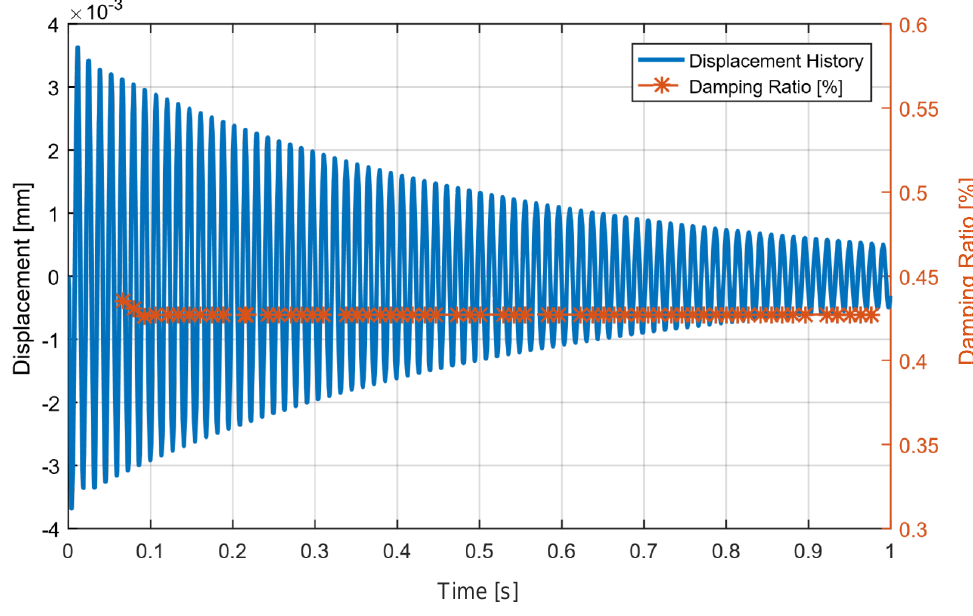
Figure 9. Free decay of a simple beam. A constant damping is reproduced.